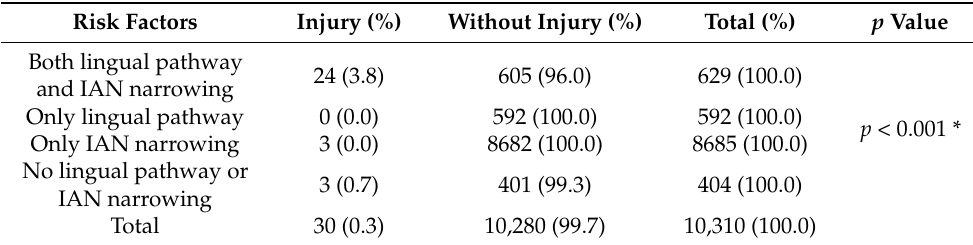
Risk factors of inferior alveolar nerve (IAN) injury in cone beam computed tomography